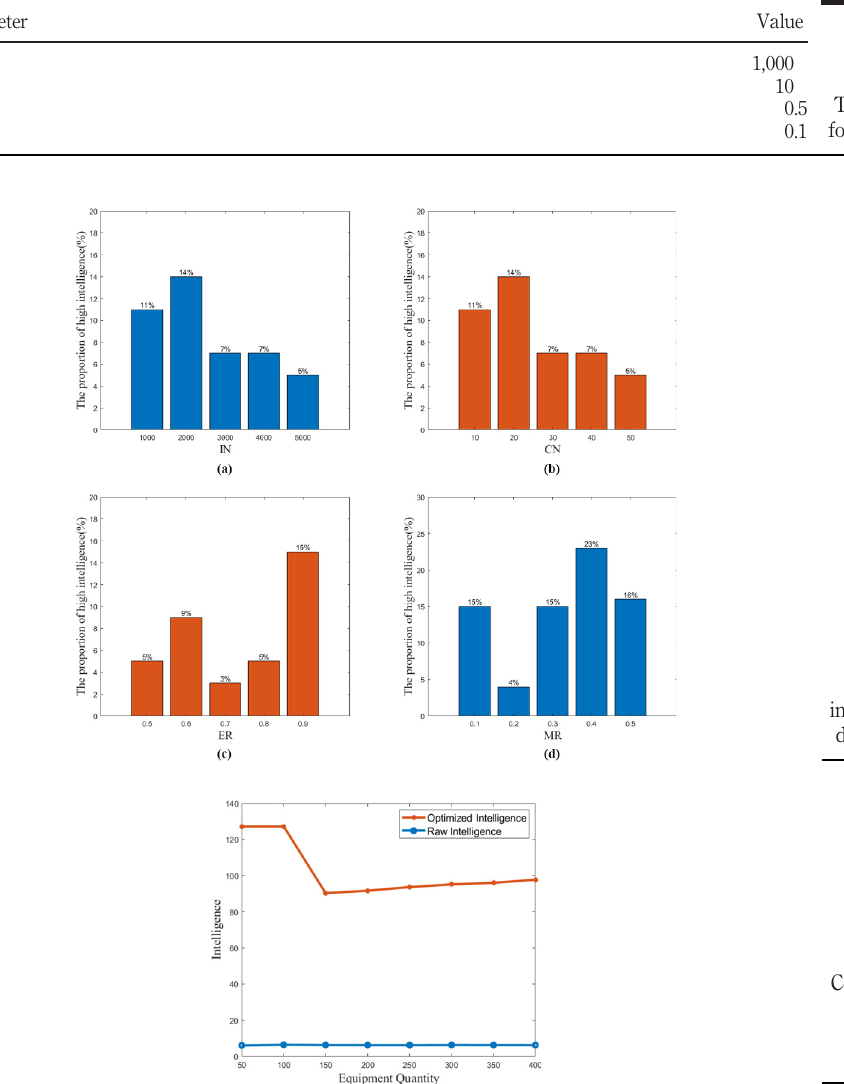
Figure 4. Proportion of high